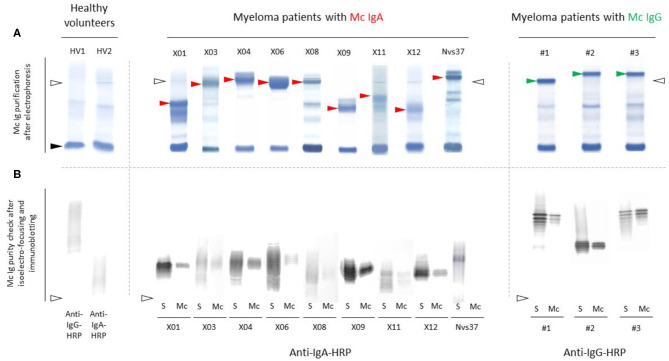
Separation of monoclonal IgAs from other Igs in serum. (A) Monoclonal IgAs (red arrowheads) and monoclonal IgGs used as controls (green arrowheads) were separated from other Igs in serum as published (9–11, 19). In the serum of healthy volunteers (HV), only polyclonal Igs are found; thus, no band is seen, only a smear. Note that monoclonal IgAs migrate in the β zone, are less well-separated than monoclonal IgGs, and thus are more difficult to purify than monoclonal IgGs. (B) The purity of monoclonal IgAs and IgGs was verified using isoelectric focusing (IEF) and immunoblotting. (A,B) Nine examples are shown for monoclonal IgAs and three for monoclonal IgGs (S, serum; Mc, monoclonal Ig separated from polyclonal Igs). Polyclonal Igs are represented by smears, whereas monoclonal Igs are represented by a single band in serum protein electrophoresis (A) and due to different migration according to different degrees of sialylation during IEF, as a stack of bands (B). The lines of sample deposit are indicated by white arrowheads. The albumin band is shown with a black arrowhead (A).